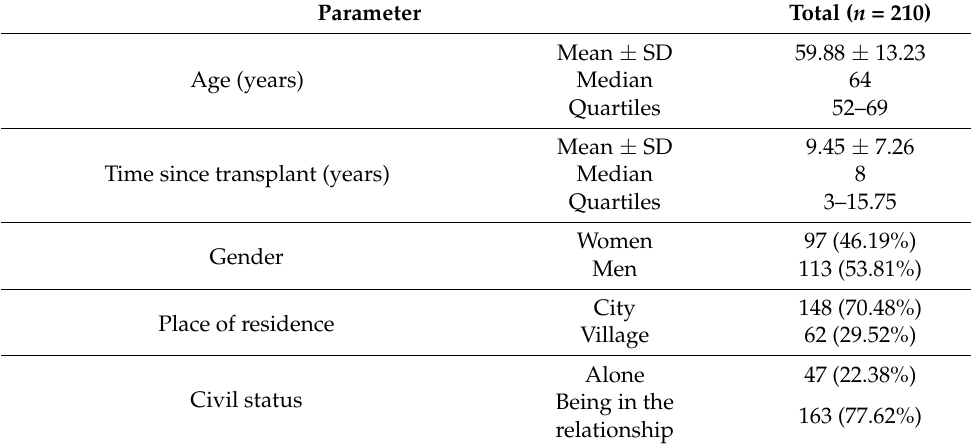
Table 2. Characteristics of